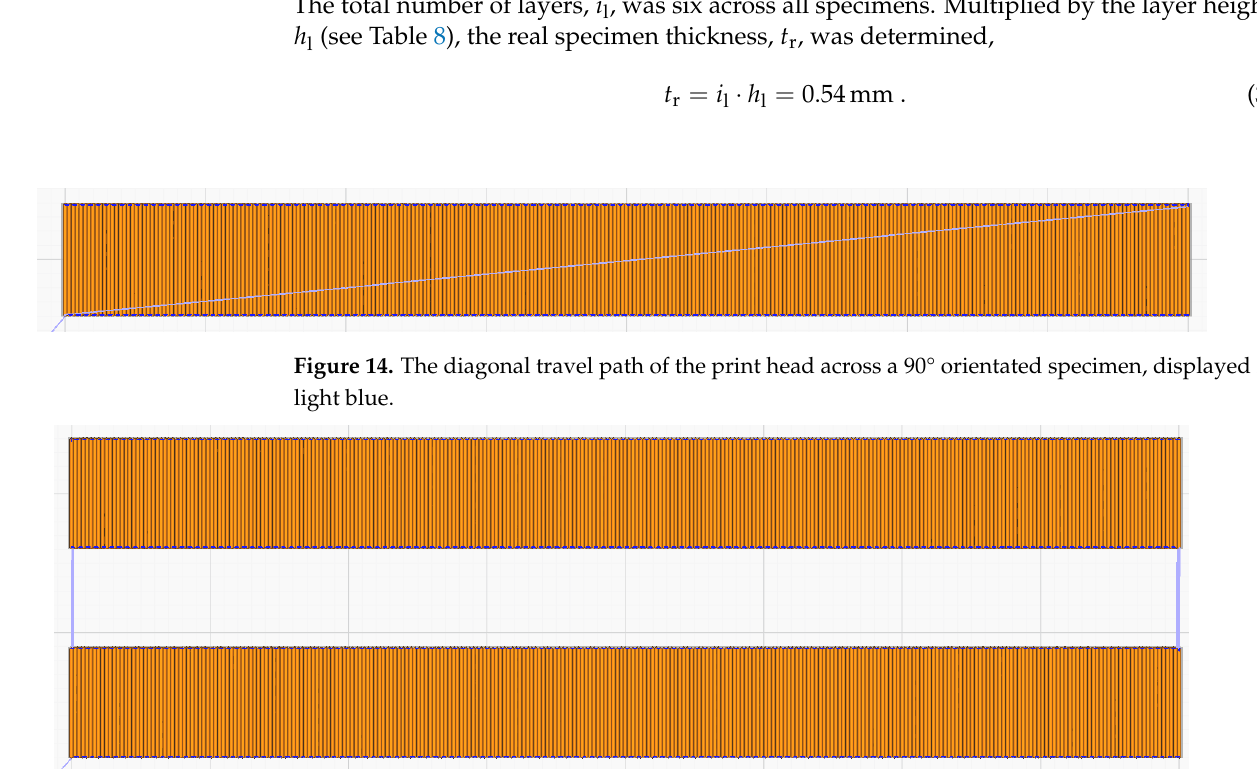
Figure 15. Optimised specimen placement for a 90° orientated specimen, which can also be applied to 0° specimens.